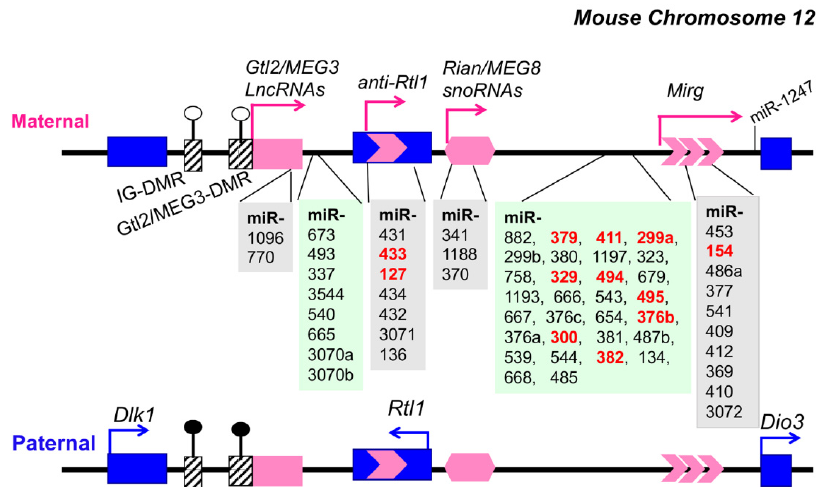
Figure 3. Schematic illustration of genomic imprinting Dlk1-Dio3 miRNAs on mouse chromosome 12. The maternally expressed non-coding genes are shown in pink (top panel), and the paternally expressed protein-coding genes are shown in blue (lower panel). The transcription direction is marked by the arrow. The IG-DMR and Gtl2/MEG3-DMR regions are indicated as rectangles with slashes. The open circle indicates hypomethylation of DMRs and black filled circle means hypermethylated DMRs. The mouse Dlk1-Dio3 harbors sixty-one miRNAs, of which sixty are at the forward strand. One miRNA, miR-1247, is located at the reverse strand. The miRNAs shaded with light gray reside within the Glt2, anti-RTL , Rian , and Mirg coding regions. The other miRNAs (shaded in light green) are located at the interval of the aforementioned coding regions. The miRNAs that were identified to be dysregulated in MRL- lpr lupus mice [77,98] are bolded in red. The scheme is not drawn to scale.